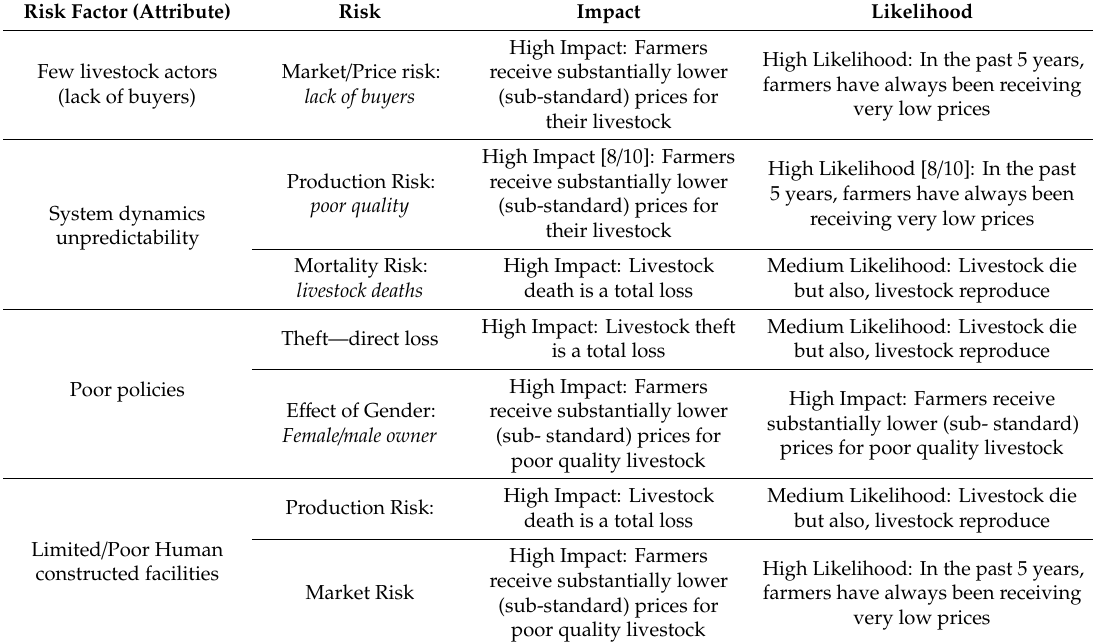
Table 3. Risk factors and likelihood impact on Smallholder Livestock